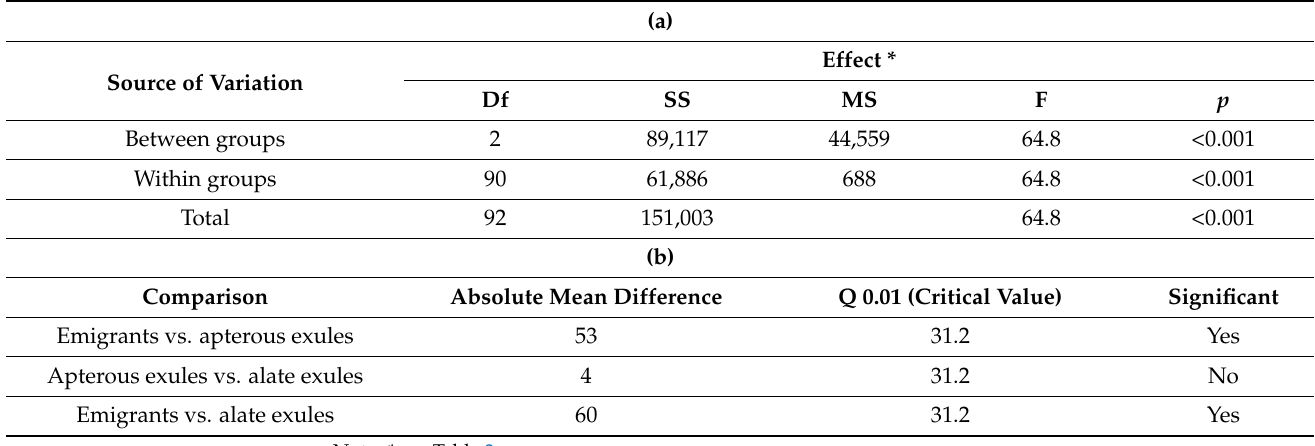
Table 4. ( a ). The results of the two-way analysis of variance (F-test) of the influences of a clone and summer morphotype on the number of Metopolophium dirhodum (Walk.) (June 2020) (Table 3) for the morphotype factor. ( b ). The differences (Tukey’s test, Q) among the summer morphotypes offspring (P14) of Metopolophium dirhodum (Walk.) (June 2020).